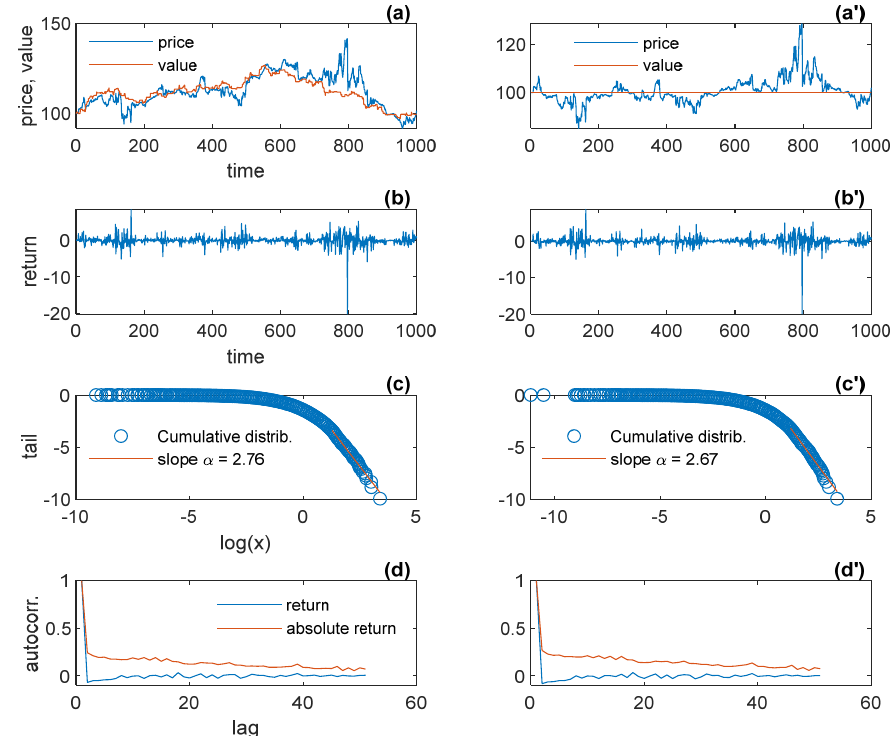
Figure 7. The general model: variable versus constant fundamental value. ( a , a’ ) price and value; ( b , b ’) return; ( c , c’ ) tail; ( d , d’ ) autocorrelation function of return and absolute return. 12 For greater visibility, only the first 1000 periods out of 10,000 are shown in the subplots (a), (a’), (b), and (b’).